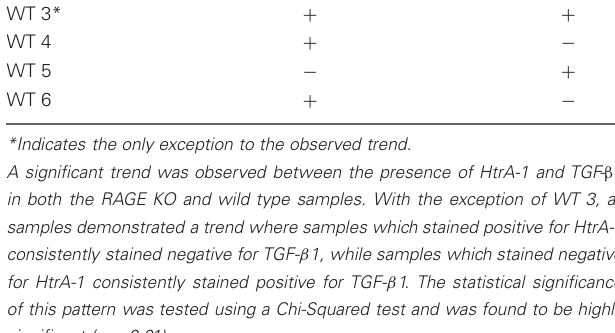
FIGURE 2 | Representative images showing the results of the immunohistochemical and histological stainings performed to analyze the presence of OA biomarkers and cartilage degradation. All tissue samples were harvested 28 days after the DMM surgery. The images selected are representative of the trends observed within wild type (A–E) ( n = 5) and RAGE KO (F–J)